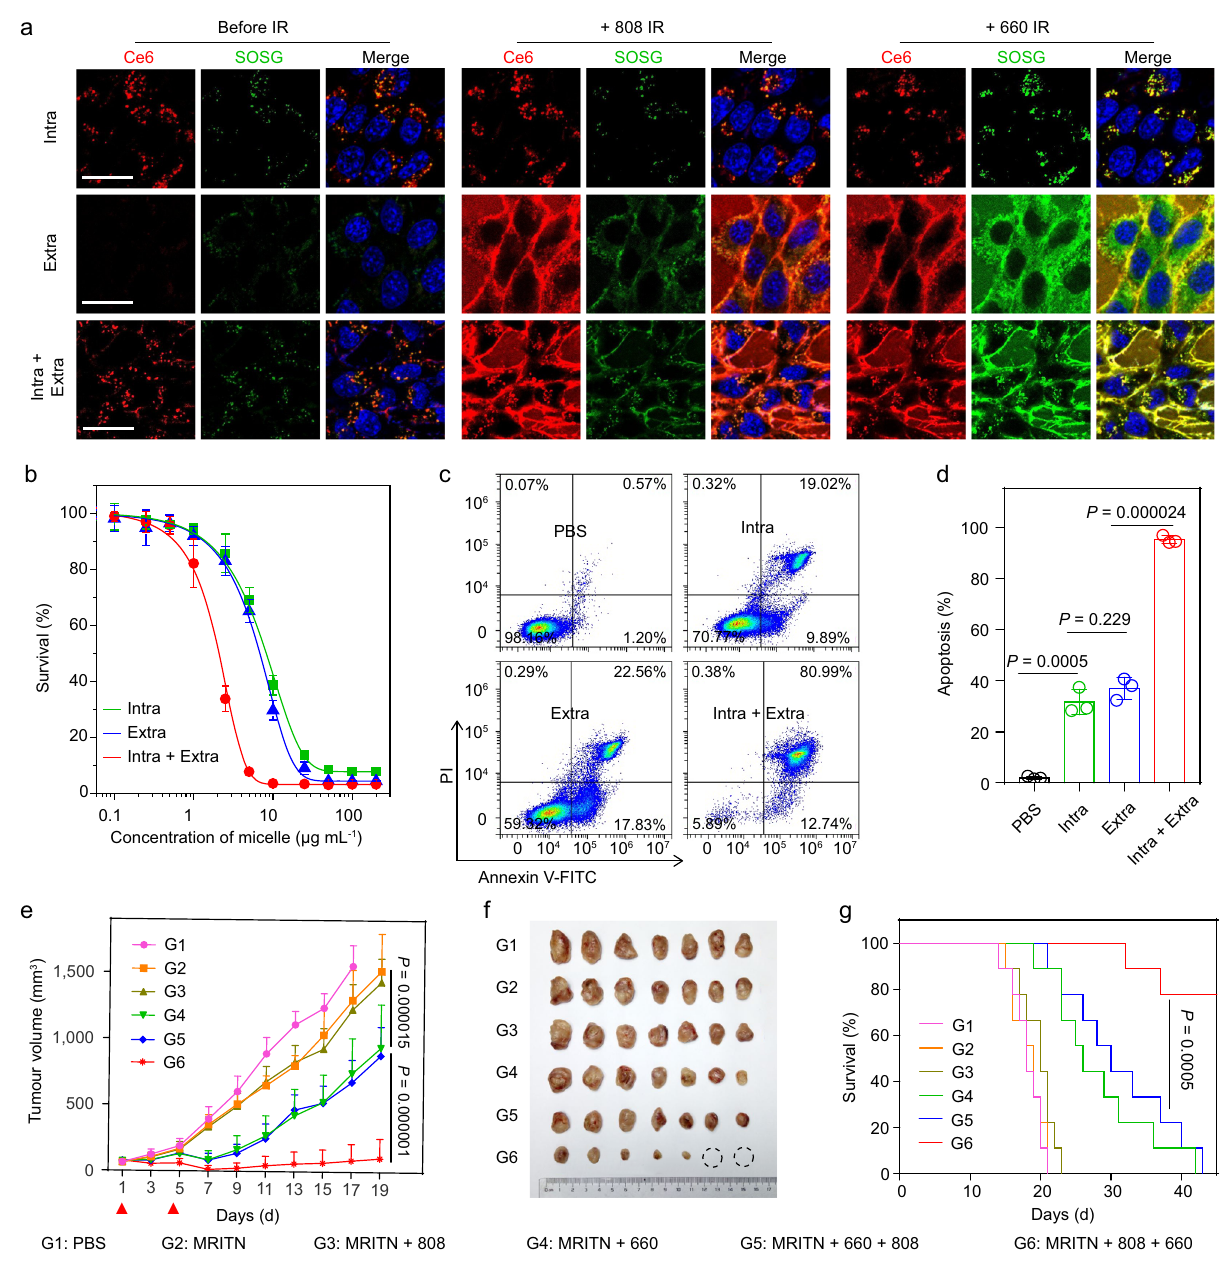
Fig. 5 Combined extracellular and intracellular photodynamic therapy for improved therapeutic outcome. a Spatially controllable Ce6/SOG activation of MRITN. Top panel: intracellular Ce6/SOG activation. Cells were incubated with MRITN at 37 °C, followed by the removal of extracellular MRITN. Middle panel: extracellular Ce6/SOG activation. Bottom panel: Combined intracellular and extracellular Ce6/SOG activation. Cells were incubated with MRITN at 4 °C (Middle panel) and 37 °C (Bottom panel) without removal of extracellular MRITN. Scale bar = 20 μ m. b In vitro cytotoxicity of MRITN with spatially controllable PDT activation. 4T1 cells were irradiated with a 660 nm laser (100 mW cm − 2 for 3 min) at 4 °C under dark conditions ( n = 3 biologically